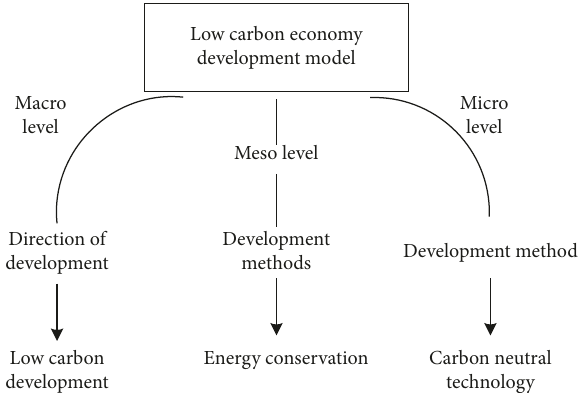
Figure 3: Low-carbon economic development model